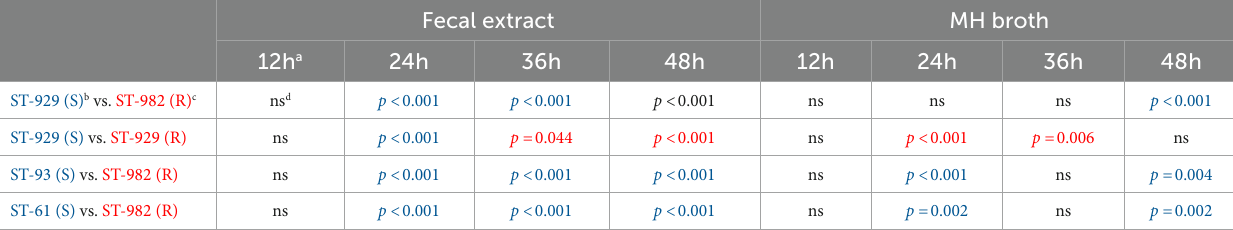
TABLE 2 Comparison of the growth kinetics of FQ-resistant vs. FQ-susceptible Campylobacter jejuni strains grown individually in bovine fecal extract and MH broth. Fecal